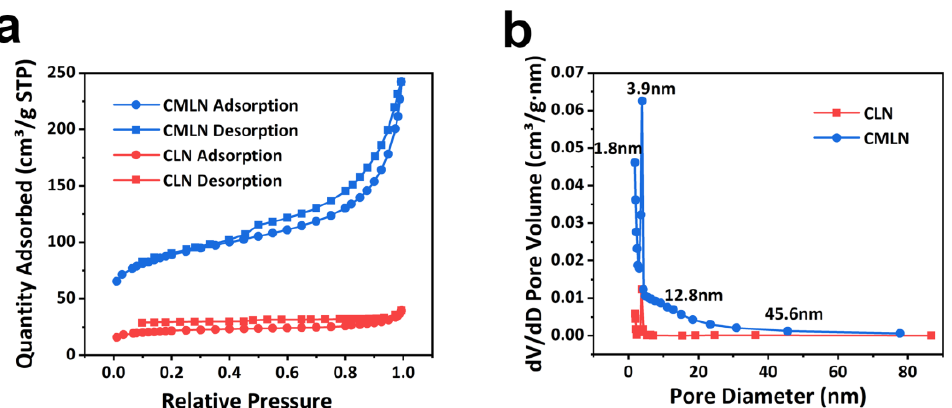
and Figure 4. ( a ) N 2 adsorption/desorption isotherm of CLN and CMLN; ( b ) pore distribution in CLN and CMLN.